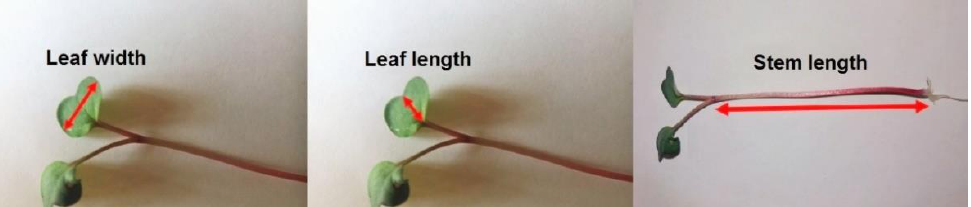
Figure 1. Cotyledon width ( left ), measured at the widest part of the leaf; cotyledon length ( middle ), measured from the leaf indentation to the beginning of the stem; stem length ( right ), measured from the first node to the beginning of the root of radish cress.